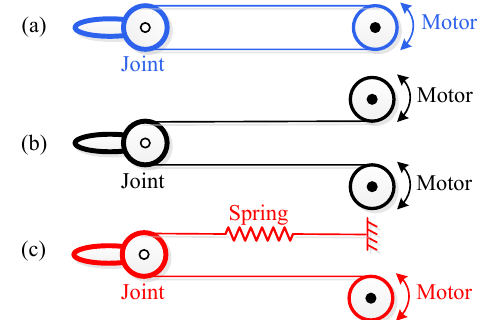
Figure 1. The three different basic cable-driven